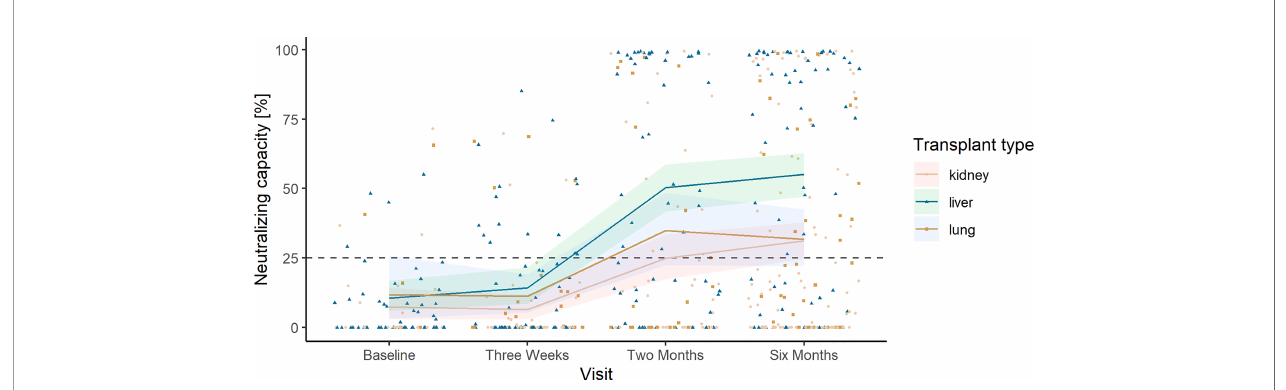
FIGURE 5 | Observed neutralizing capacity and predicted mean neutralizing capacity in liver, kidney, and lung transplant recipients. Development in predicted mean neutralizing capacity represented in percent plotted on top of the observed individual neutralizing capacity at each sample time from liver (green/triangle), kidney (yellow/circle), and lung transplant recipients (brown/square). The dashed horizontal line indicates the minimum threshold for positive